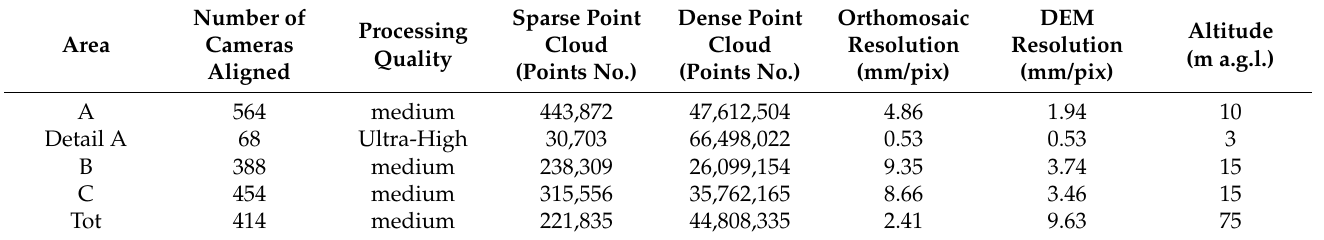
Table 1. Characteristics of the products obtained from Agisoft Metashape Professional Software, version 1.7.2 (St. Petersburg, Russia)